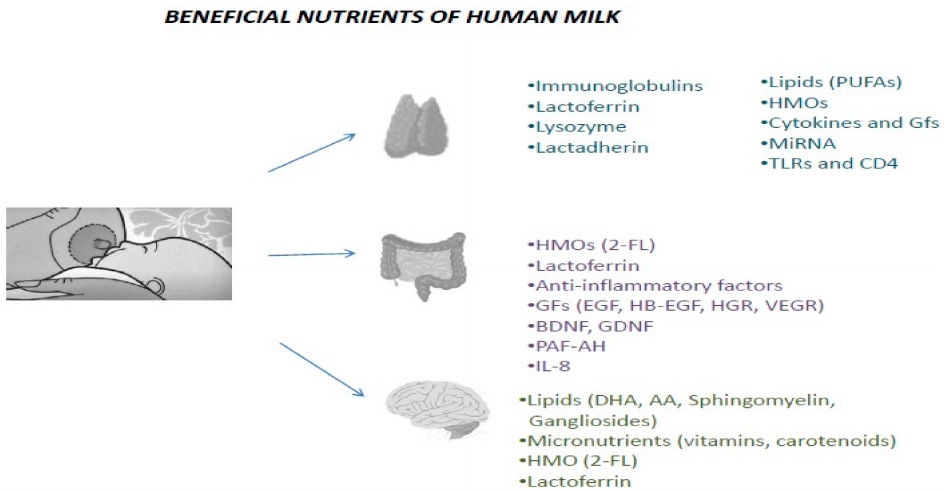
Figure 2. Nutrients of HBM that provide passive immunity, have anti-inflammatory action and induce the maturation of immune, gastrointestinal and nervous systems in VPIs